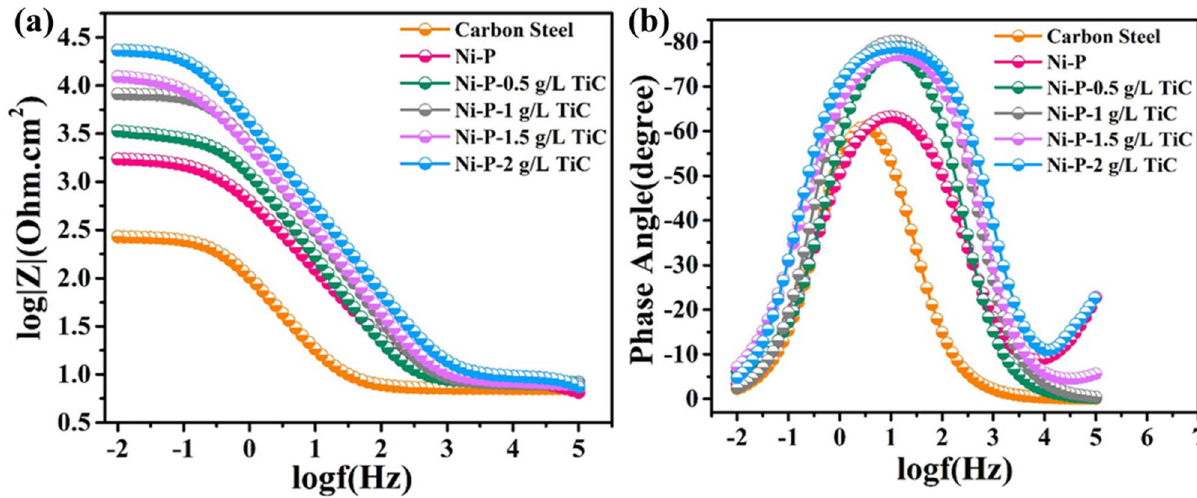
Figure 12. ( a ) Bode plots of the substrate, Ni–P, and Ni–P–TiC composite coatings containing the magnitude plot and ( b ) phase angle plot after 2 h of immersion in 3.5wt% NaCl solution.